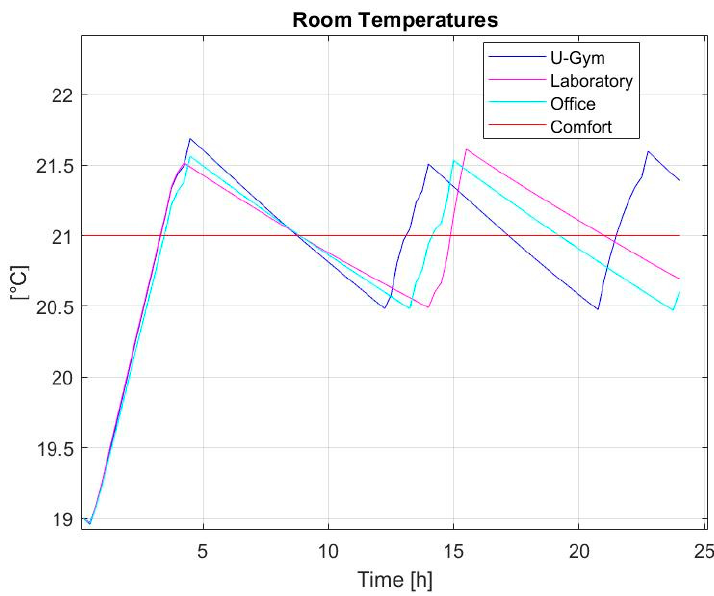
Figure 18. Room temperature profiles in the case of standard HVAC plant control logic. Table 4. Discomfort indicator